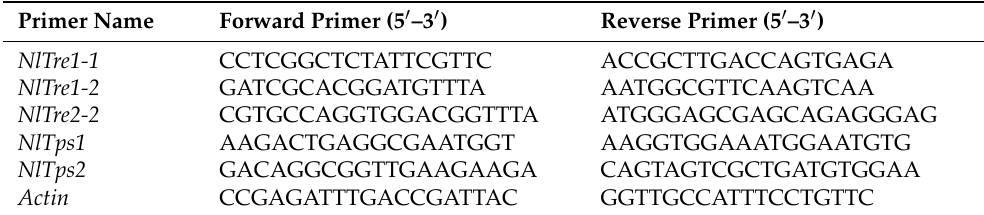
Table 1. Primers for quantitative real-time polymerase chain